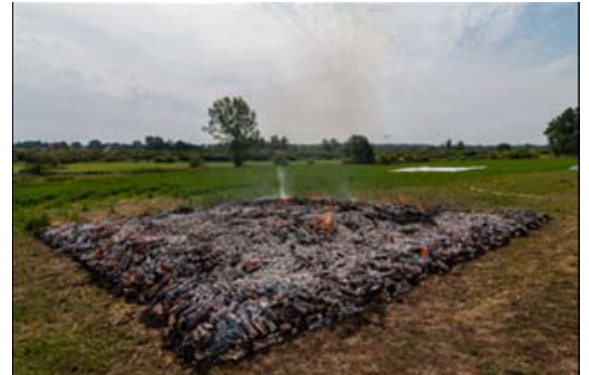
Figure 1. Test fire in the DEMMIN area